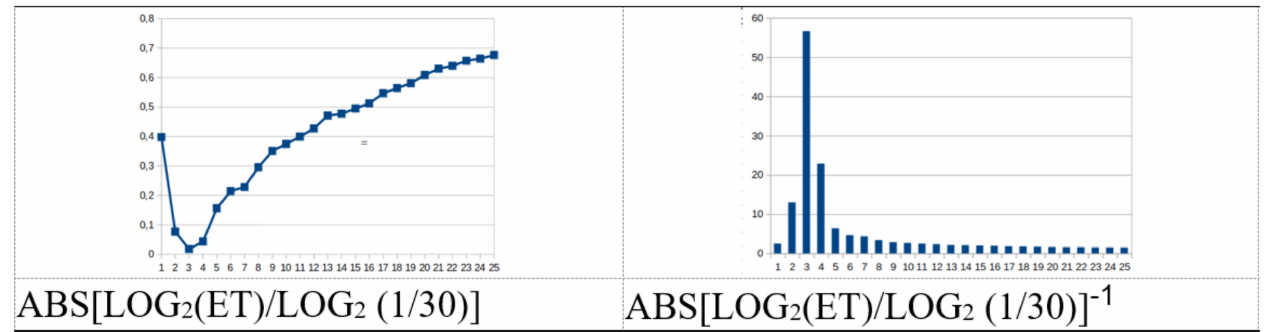
Figure 6. Dimension with ET for test